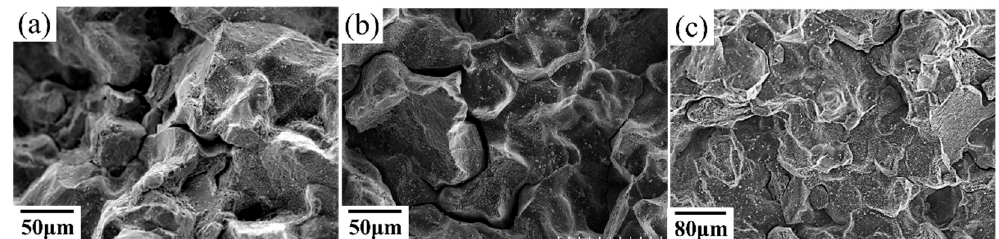
Figure 14. Rupture surfaces of ( a ) 1180/4 h, ( b ) As-HIPed, and ( c ) HIP+ direct aging specimens under 550 MPa at 650 °C.